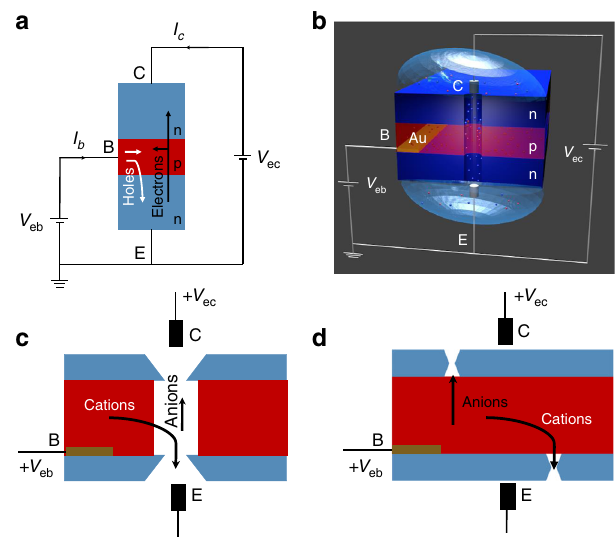
Fig. 1 Design of an ionic bipolar junction. a Scheme of a solid-state npn bipolar junction transistor in the active mode; C, E, and B indicate collector, emitter and base, respectively. V eb and V ec denote voltage between emitter and base, and emitter and collector, respectively. I c is the collector current, and I b is the input current. b Scheme of an ionic equivalent of an npn transistor with voltages, V eb , V ec , as applied in the experiments. V eb is applied through the Au gate electrode shown in orange. Blue regions of the device correspond to a zone with positive surface charges that lead to accumulation of anions (marked as blue dots); the red region is negatively charged and fi lled with cations (marked as red dots). A zone fi lled with anions is an ionic equivalent of an n doped semiconductor; a zone fi lled with cations is an ionic equivalent of a p doped semiconductor. c Arrangement of two 40 nm thick silicon nitride chips (shown in blue) and the Na fi on fi lm (red) used in the ionic transistor. A pore through the silicon nitride and Na fi on sandwich was drilled by focused ion beam. Silicon nitride was modi fi ed chemically to render the surface positively charged. Na fi on is negatively charged thus expected to be fi lled with cations. d Device scheme for the transistors with smaller pore size. This transistor was assembled using two silicon nitride chips with nanopores drilled prior to the device assembly. A Na fi on layer is present between the two chips, similar to the arrangement shown in c